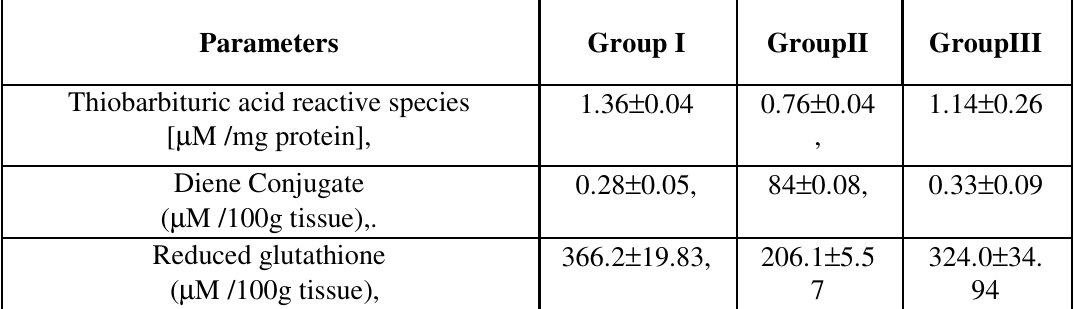
Table 1: Effects of Ethanol extract of leaf of Cajanus Indicus Spreng on the antioxidant